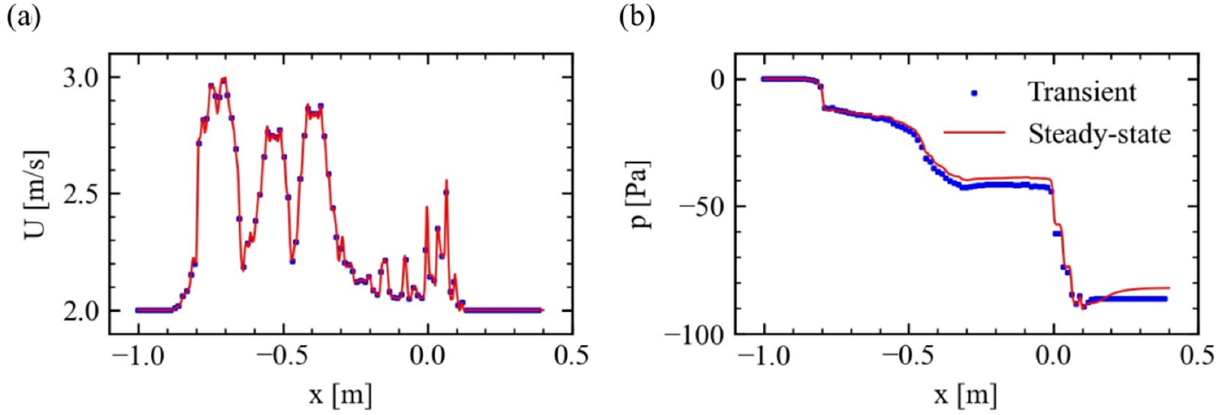
Figure 9. Comparison of ( a ) velocity and ( b ) pressure distributions obtained from steady-state and time averaged transient simulations.